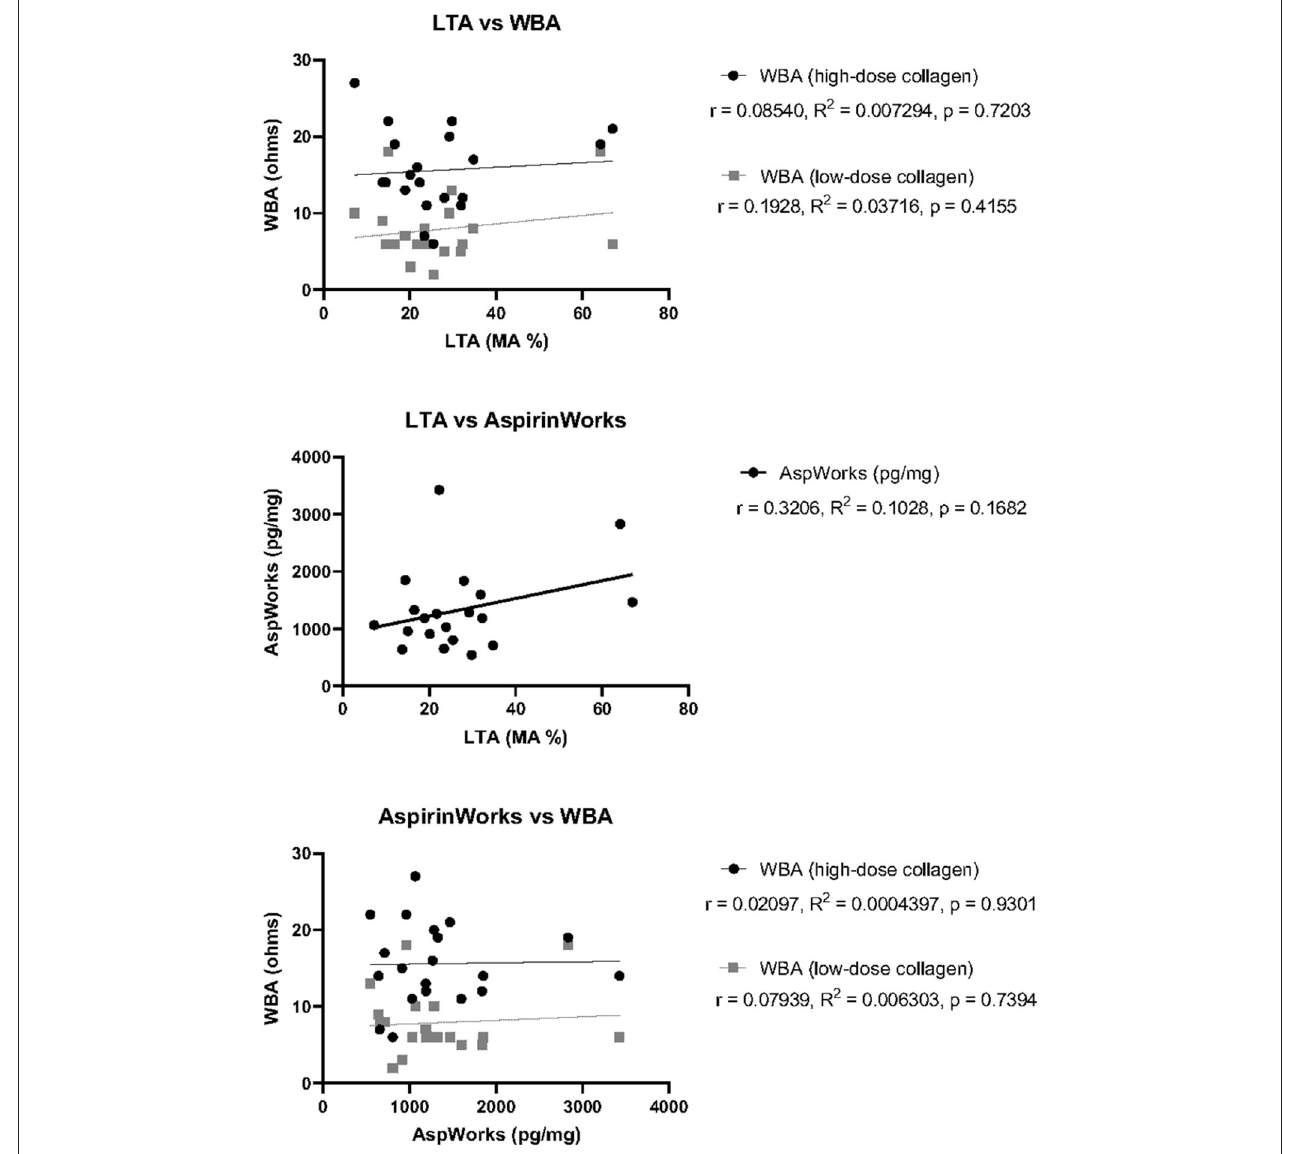
FIGURE 2 | Correlation of ASA response test measurements between three test platforms. Pearson’s correlation coefficient (r), goodness of fit by simple linear regression (R 2 ), and statistical significance (p) was calculated for each pair of tests using the raw measurement values obtained for each patient. Top: LTA against either WBA with high-dose collagen (black) or low- dose collagen (gray). Middle: LTA against AspirinWorks. Bottom: AspirinWorks against either WBA with high-dose collagen (black) or low-dose collagen